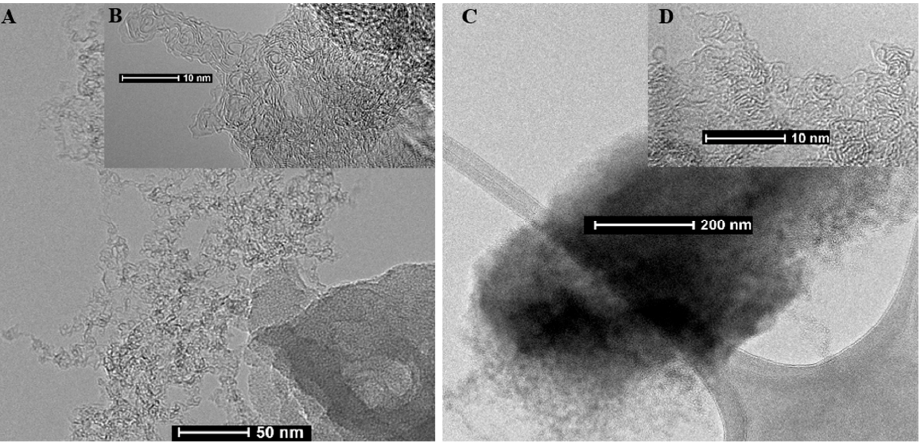
Figure A8. TEM micrographs after laser heating with 100 mJ/cm 2 —( A , B ) anthracene coke ( C , D ) and sucrose char.